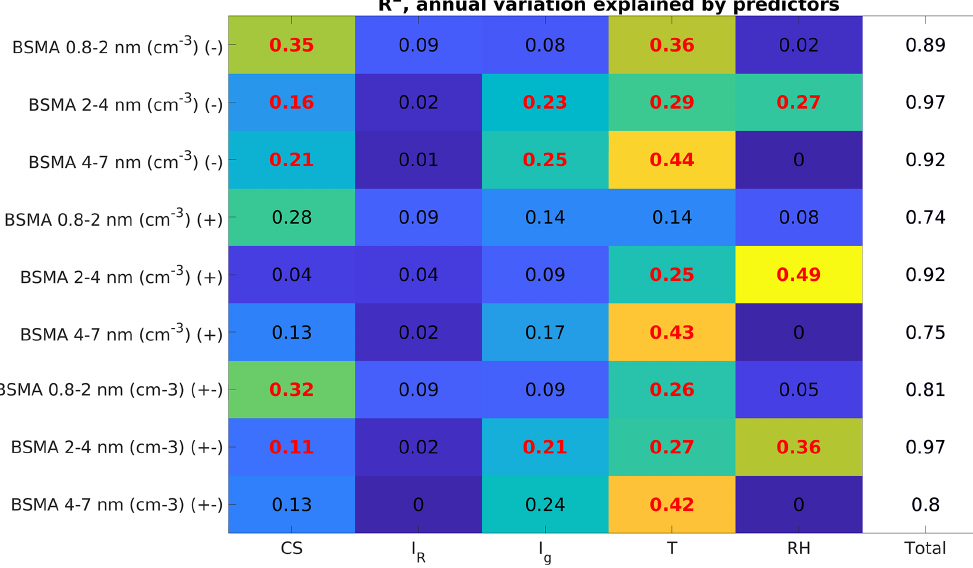
Figure 9. The amount of seasonal variation explained by our chosen explanatory variables for each size range and polarity. The symbol ( − ) denotes negative polarity, ( + ) a positive polarity, and ( ± ) the sum of both polarities. The bolded red values are statistically significant ( p < 0 .